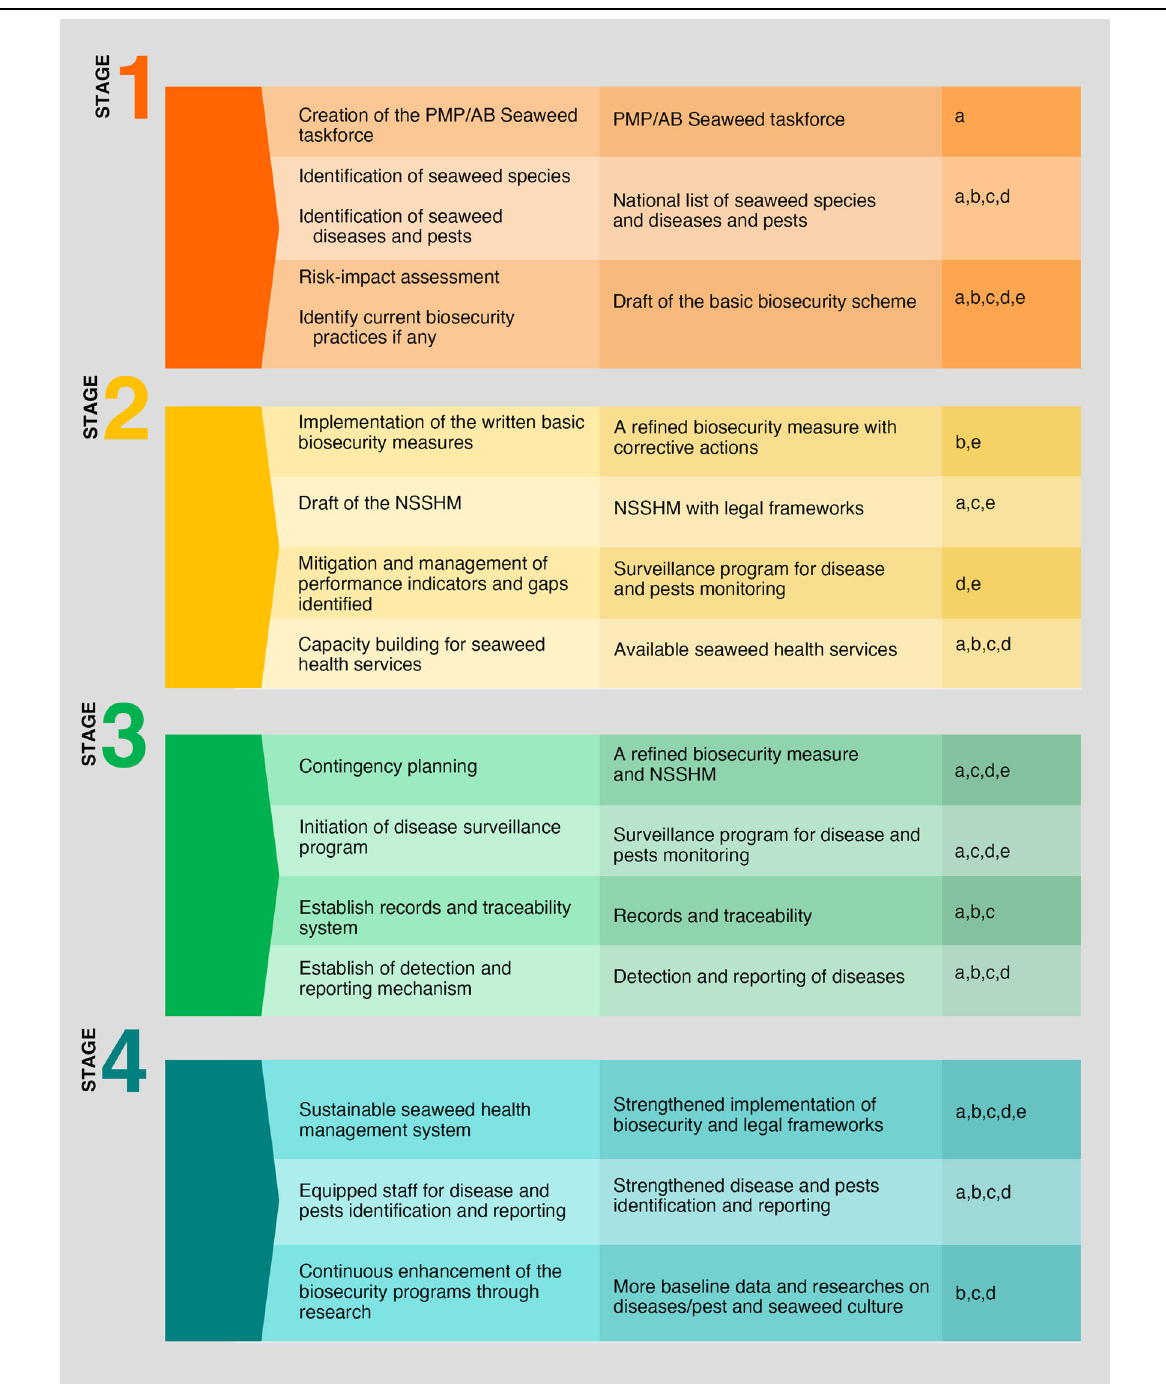
Fig.2|ThefourstagesoftheProgressiveManagementPathwayforimproving Seaweed biosecurity (PMP/AB-Seaweed), including; the processes and steps,